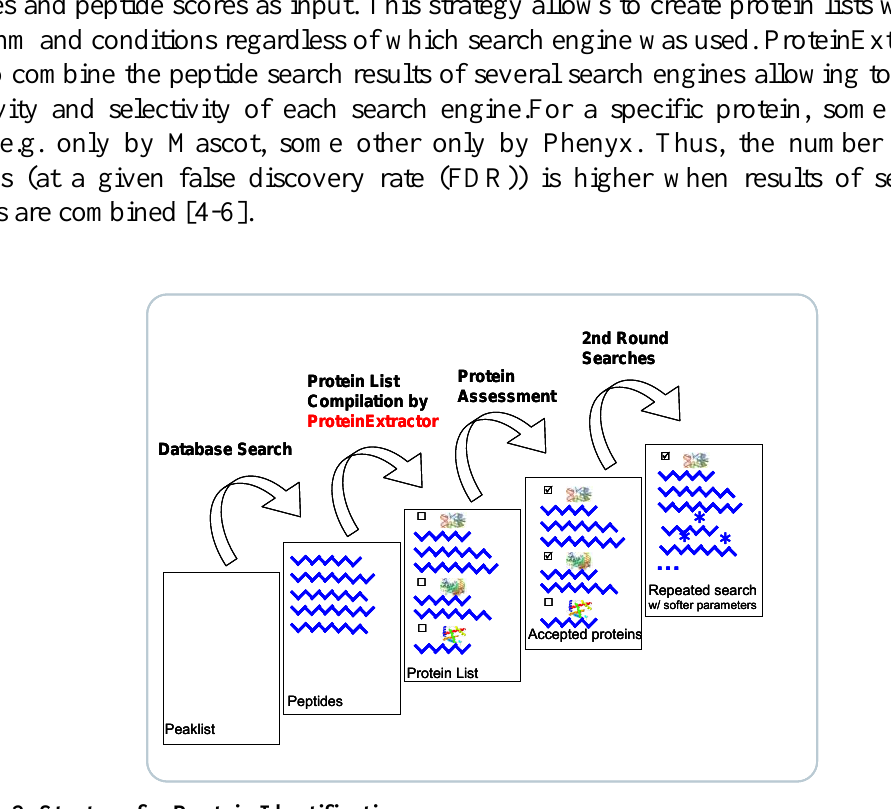
Fig. 2: Strategy for Protein